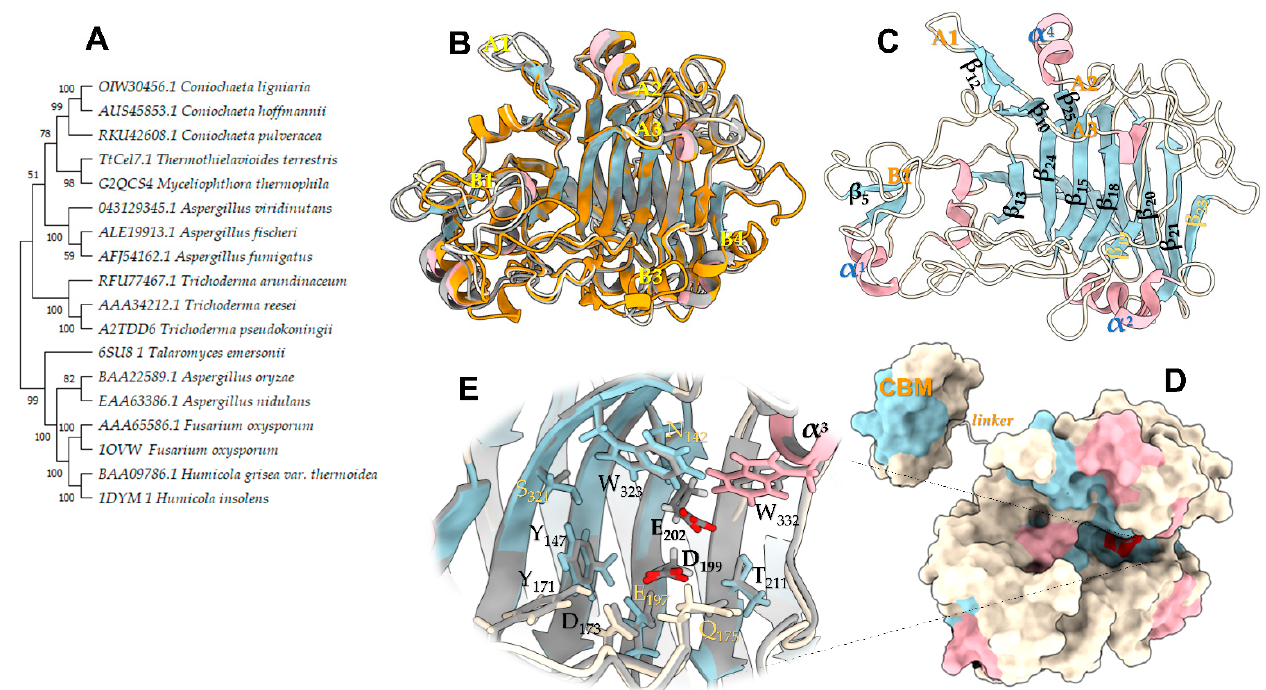
Figure 2. Phylogenetic analysis and homology model of the endoglucanase Tt Cel7B. ( A ) Phylogenetic tree of Tt Cel7B ( Tt Cel7.1) and close CAZy GH7 proteins. The sequences were retrieved from GenBank, Uniprot, and PDB. ( B ) A 3D model of Tt Cel7B of superimposed with template structures from T. harzianum [PDB id 5W0A], R. emersonii [PDB id 6SU8], and F. oxysporum [PDB id 1OVW]. ( C ) Modeled structure, in the same orientation as in panel ( B ), with the β -strands, α -helices, and main loops highlighted. ( D ) Space-filling model of panel ( C ) linked with the cellulose-binding module (CBM). ( E ) Zoom-in of the modeled catalytic tunnel. Figure was prepared using UCSF